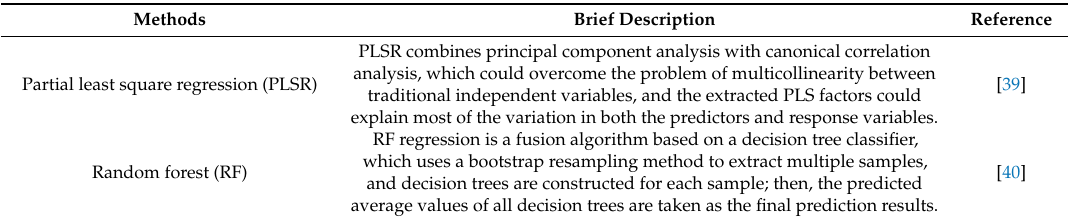
Table 4. Summary of the MLRA algorithms investigated in this